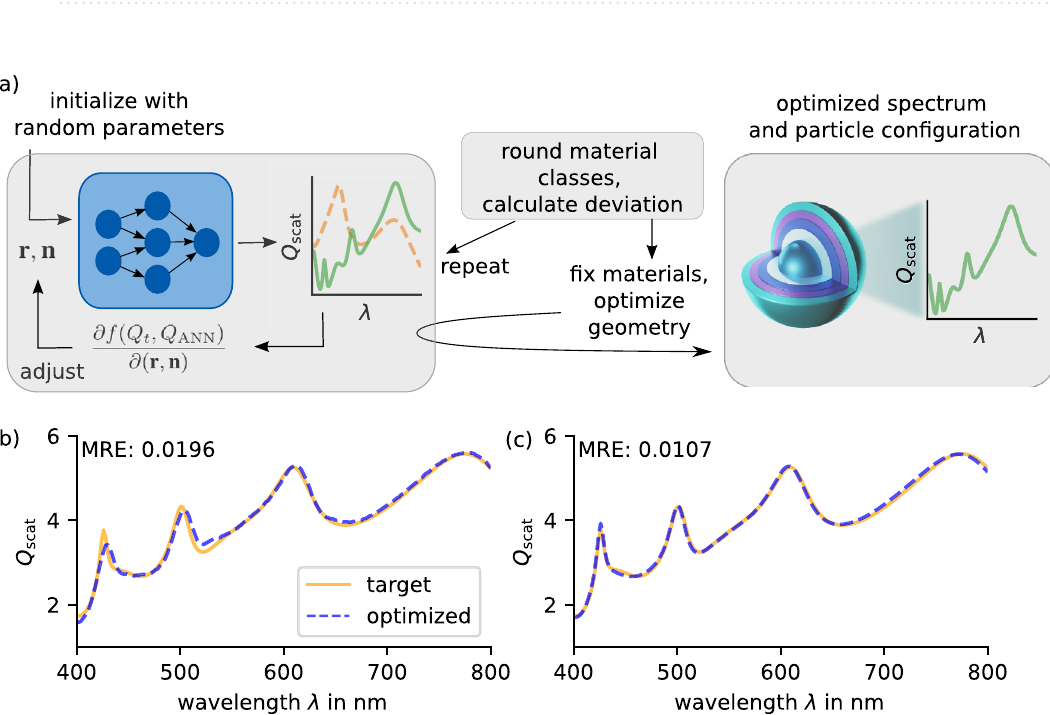
Figure 2. ( a ) Inverse design optimization scheme targeting the scattering response of a core-shell particle made from a core and four shells. In the first step, we initialize the neural network with some random parameters and minimize the deviation of the resulting output spectrum and the target by varying all input parameters. If the final spectrum is close enough to the target, we round and fix the material classes and fine-tune the geometry in a second optimization step. Example optimization and its results after the first ( a ) and second ( b ) optimization steps. The parameters used in this example are shown in Table